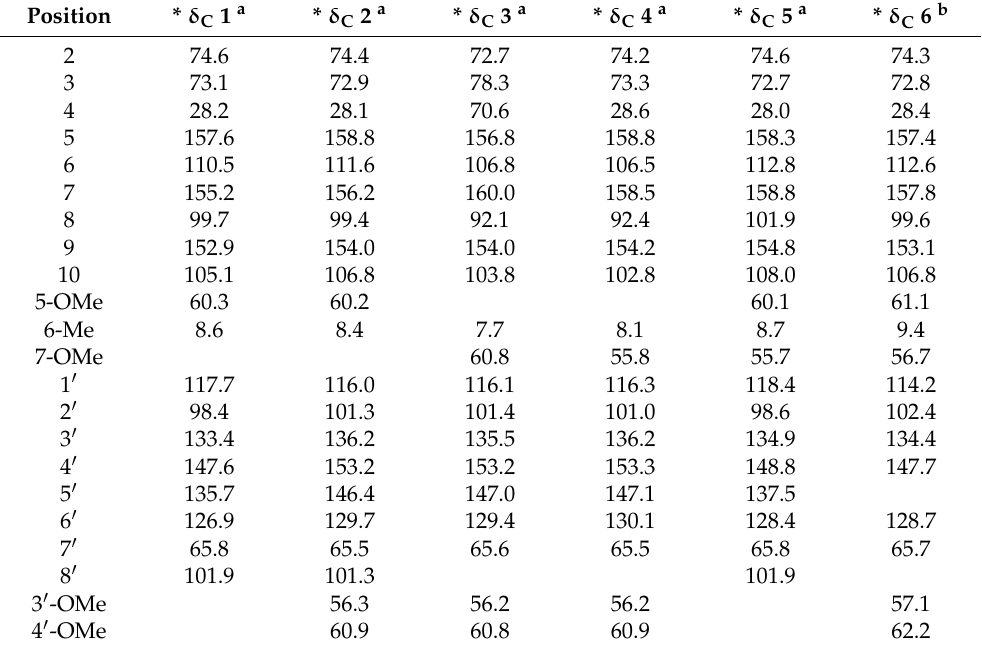
Table 2. 13 C NMR data for compounds 1 – 6 .